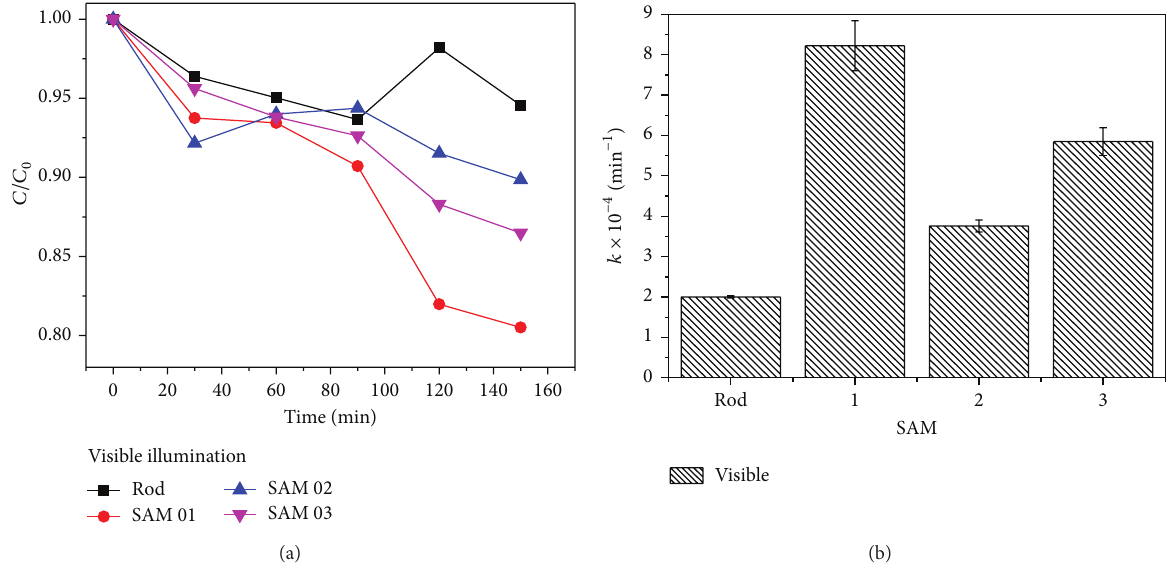
Figure 8: Photodegradation profiles of the Rhod-B solution, using TiO 2 nanoparticles with visible light (a) and column graphic of k values under visible illumination for Rhod-B (values 10 −1 lower under visible illumination than under UVC illumination)